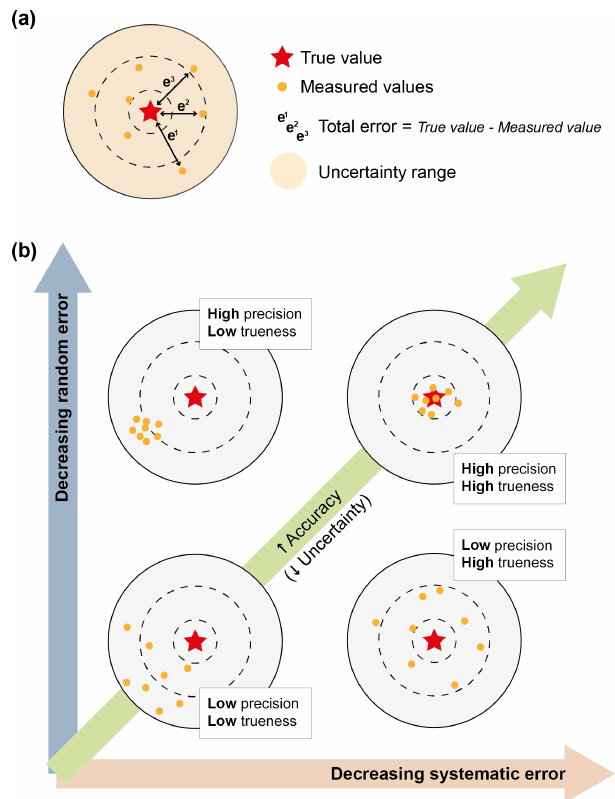
Figure 1. Visual representation of (a) the difference between error and uncertainty and (b) the relationships between commonly used quality descriptors and performance